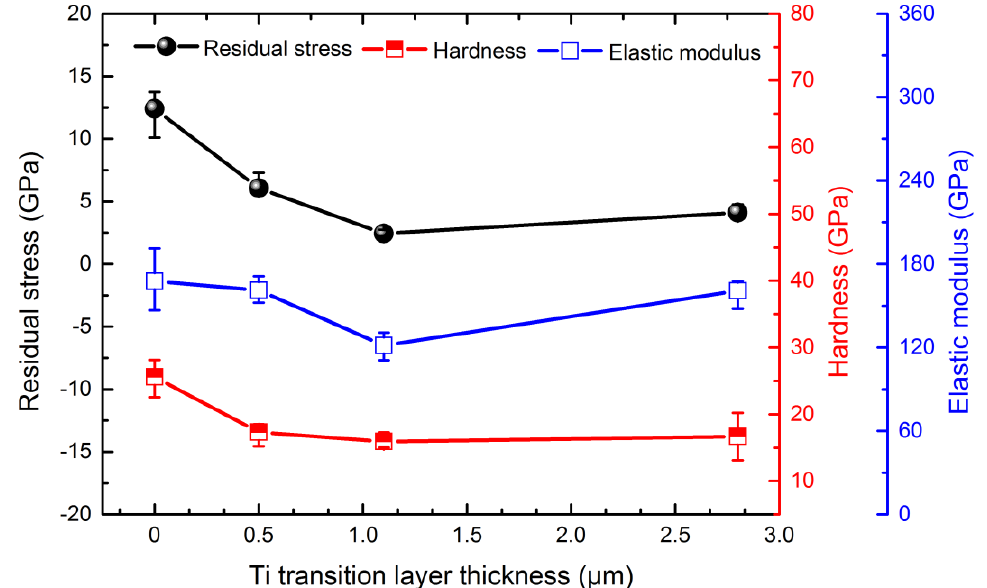
Figure 9. Residual stress, hardness and elastic modulus of Ti-DLC coatings with various Ti transition layer thicknesses ( t 0